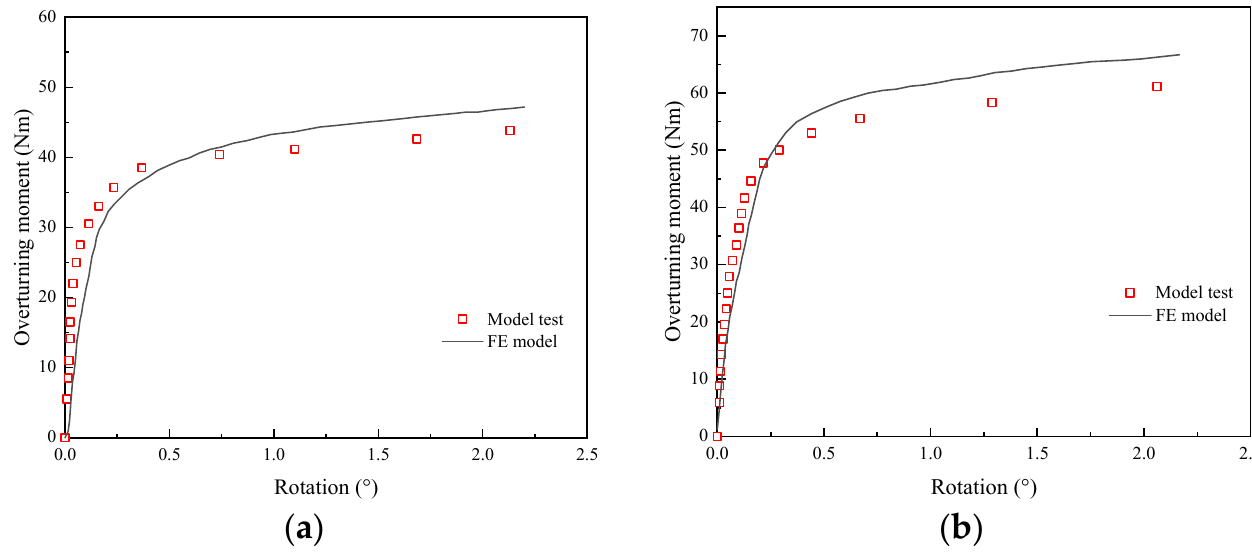
Figure 11. Comparison of measured and computed moment-rotation response of 1 g test: ( a ) one bucket in tension, ( b ) two buckets in tension.